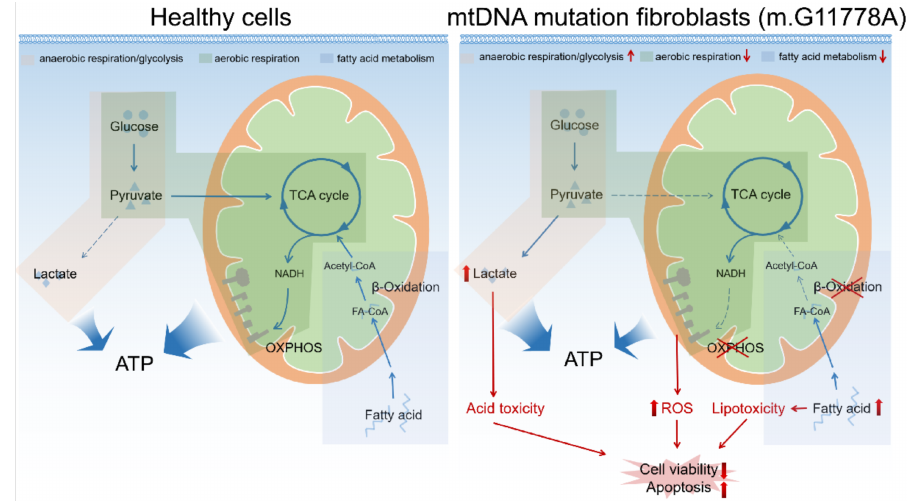
Figure 8. Graphical summary of metabolism changes in LHON fibroblasts bearing